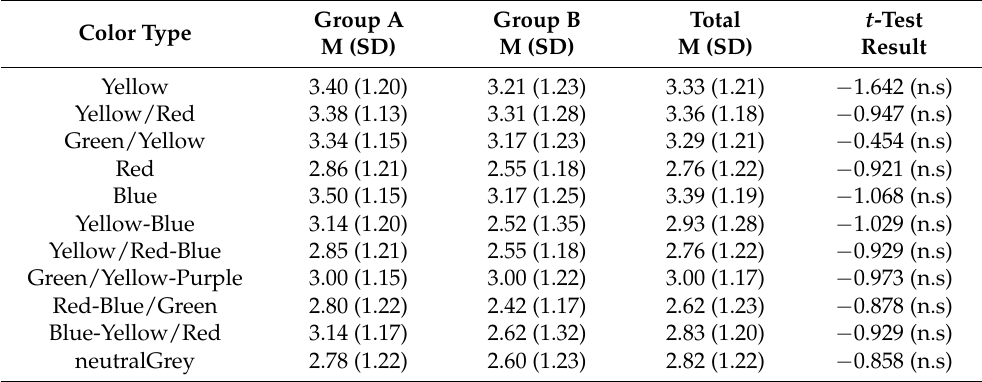
Table 3. The score of ‘Pleasure’ for stimuli color images.